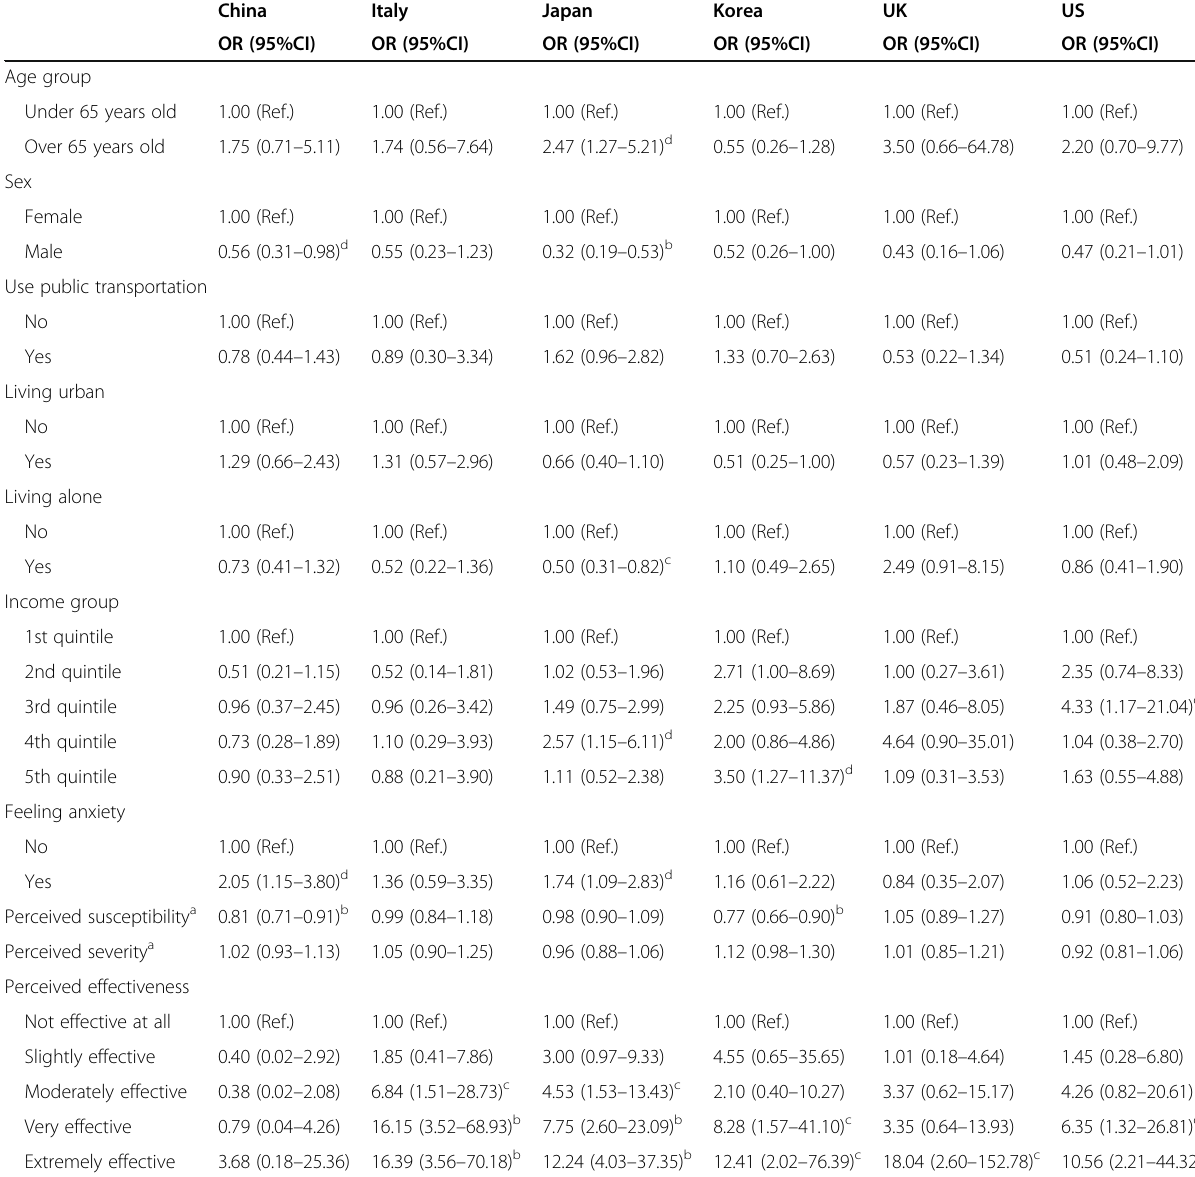
Table 4 Associations between public perceptions, personal characteristics, and handwashing/using hand sanitizers